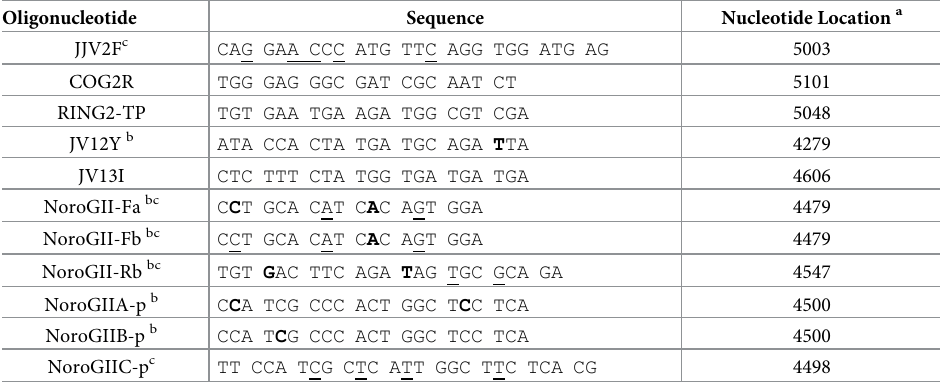
a Locations are aligned with Snow Mountain Virus (GenBank AY134748.1) b Bold refers to the correct corresponding match to degenerate base. c Underline refers to base